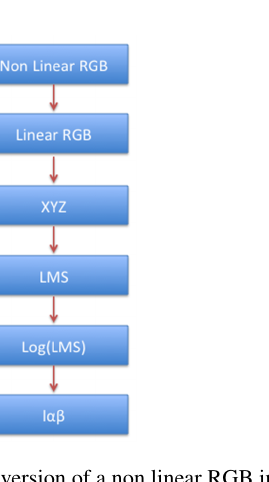
Figure 3: Flow-chart: conversion of a non linear RGB image in l αβ space.